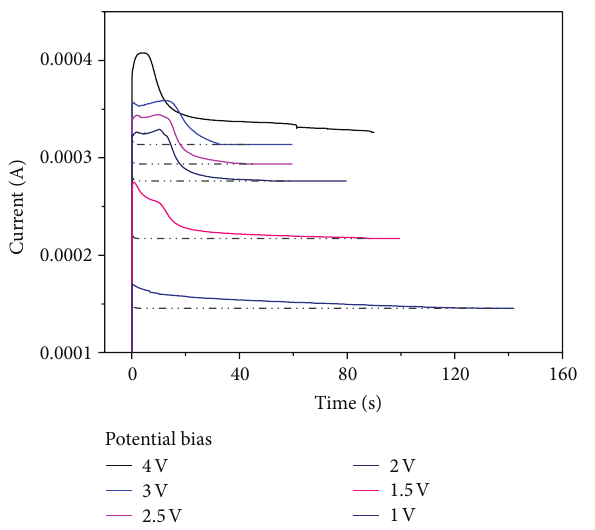
Figure 3: Photocurrent responses of a 2 mol/L NaNO 3 blank solution containing benzoic acid (0.4mmol/L) in the thin-cell reactor based on the TNA electrodes at different fixed applied bias potentials under bias voltages under illuminations of 7.9mW/cm 2 .